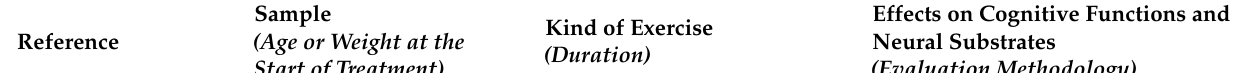
Table 3. Studies on land activity effects on cognitive functions and neural substrates of healthy